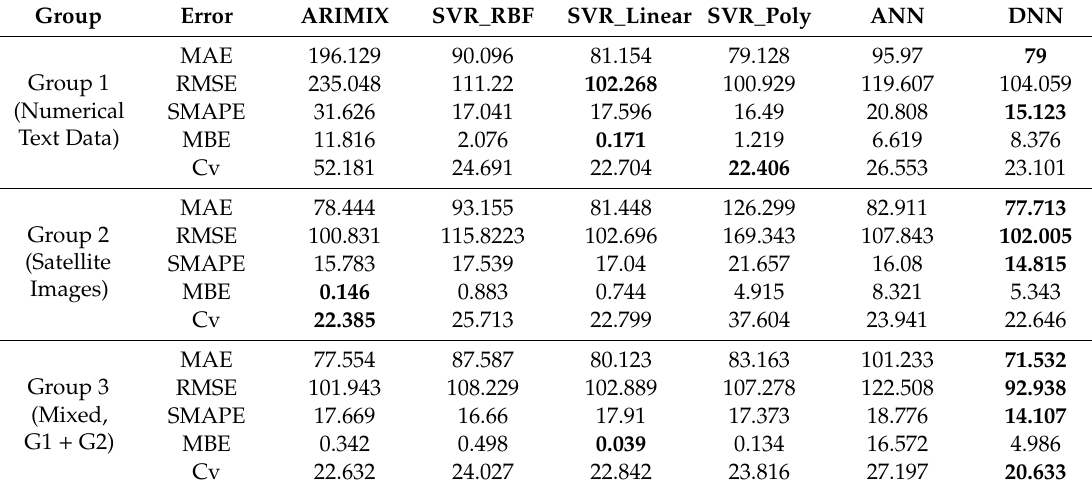
Table 12. Solar PV generation prediction result of case